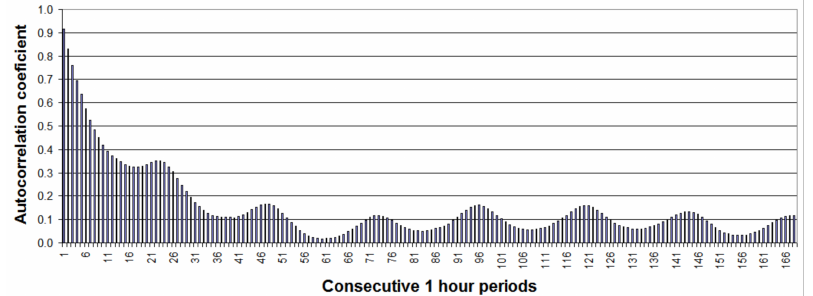
Figure 2. Autocorrelation function (ACF) of the wind turbine energy generation time